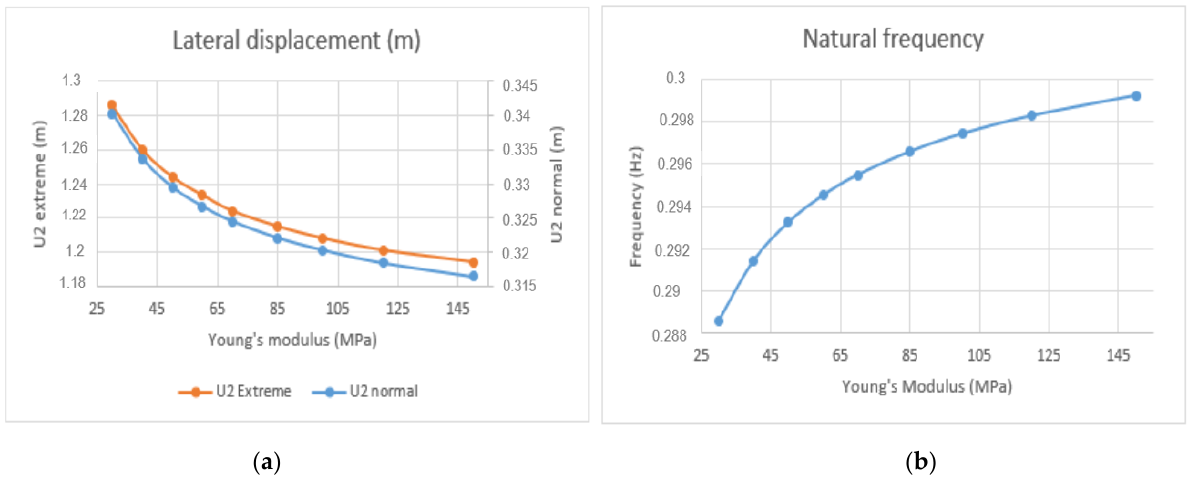
Figure 16. Influence of Young’s modulus E: ( a ) Lateral displacement, ( b ) Natural frequency.